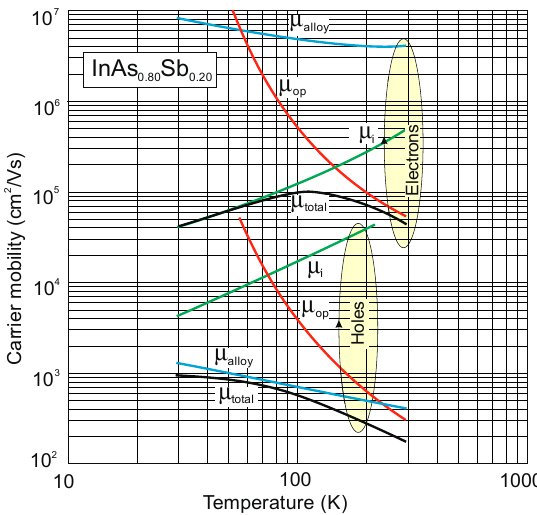
Figure 15. Modeled mobility versus temperature for electrons and holes in undoped InAs 0.80 Sb 0.20 .